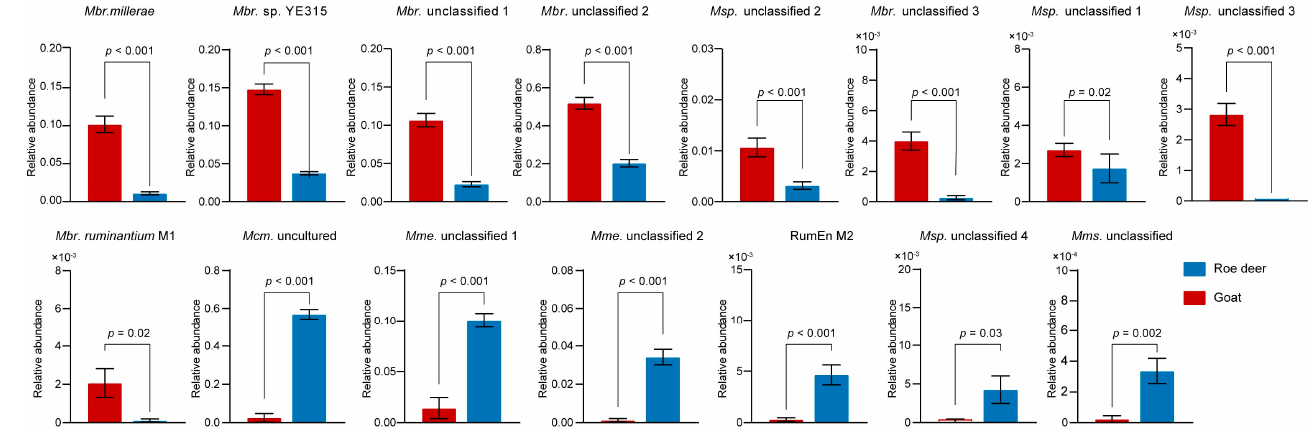
Figure 5. The significantly different methanogen species in feces between roe deer and goats. The significances were determined using the Mann–Whitney test based on the Benjamini–Hochberg corrected p -values.